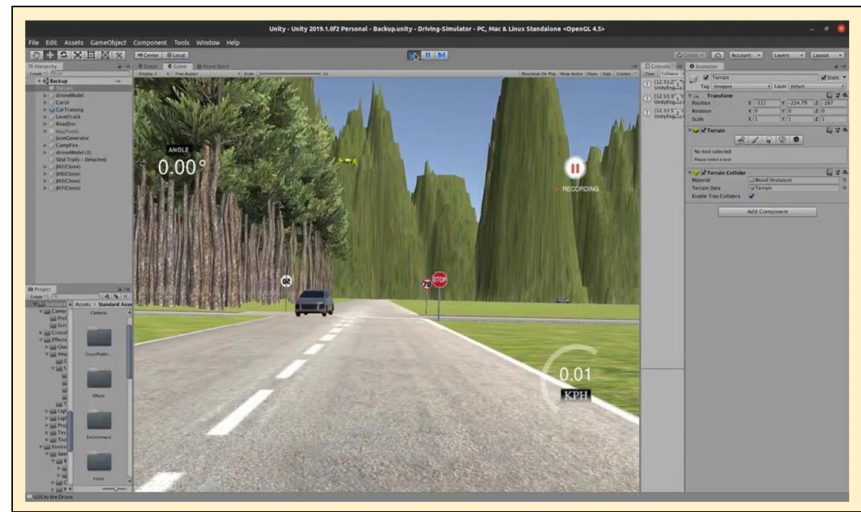
Figure 22. A scene in the simulator (i.e., normal driving).